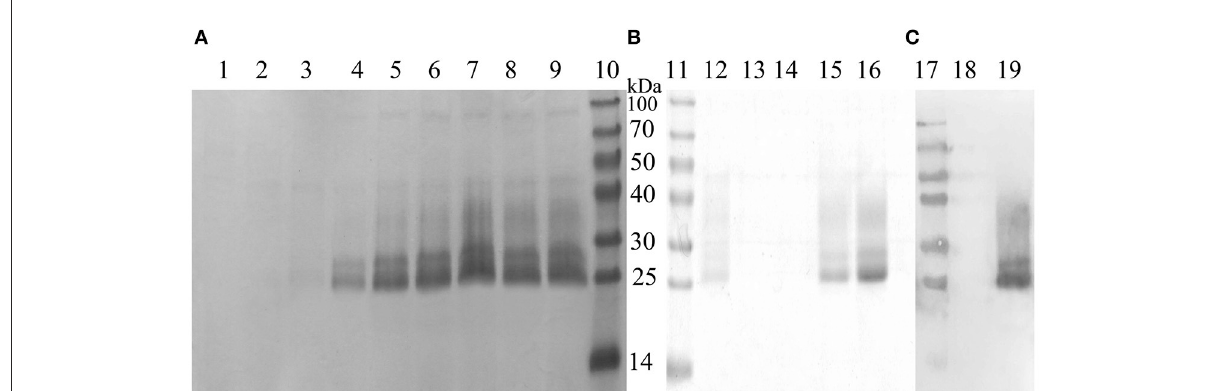
FIGURE3 Identification of recombinant MiIFN- α expression and purification by SDS-PAGE and western blotting. (A,B) Yeast expression and purification of MiIFN- α was observed by SDS-PAGE. Lane 1: empty vector-induced control; Lane 2: recombinant yeast non-induced control; Lane 3: 6h induced supernatant; Lane 4: 12h induced supernatant; Lane 5: 24h induced supernatant; Lane 6: 48h induced supernatant; Lane 7: 72h induced supernatant; Lane 8: 96h induced supernatant; Lane 9: 108h induction of supernatant; Lanes 10 and 11: protein molecular weight standards; Lanes 12–14: Eluted with binding buffer; Lanes 15 and 16: recombinant MiIFN- α purified by NTA-Ni chromatography at elution buffer pH 7.4. (C) Identification of the expressed product by western blotting. Lane 17: protein molecular weight standards; Lane 18: empty vector induced control; Lane 19: purified target.